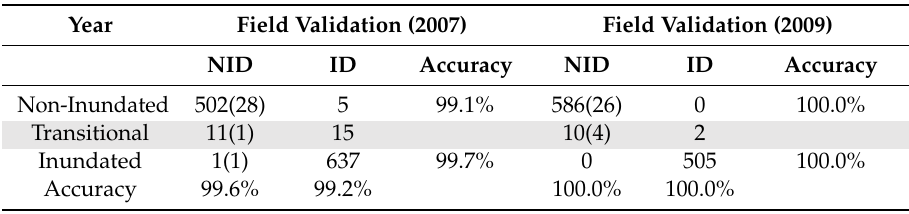
Table 1. Error matrices for 27 March, 2007 (left) and 24 March, 2009 (right). Field data indicating non-inundated (NID) and inundated (ID; top), are compared with map classes (side). Evergreen sites are indicated separately using parentheses, and were added to directly adjacent values when computing accuracy. User’s accuracy (i.e., how often the mapped class will be found in the field) is displayed vertically and producer’s accuracy (i.e., how often classes in the field are correctly classified in a map) is displayed horizontally. Overall accuracy is 99.4 % and 100.0 % for 2007 and 2009, respectively. Data for transitional field sites are indicated in gray. These numbers are included for visual reference only, and are not included in any derived estimates of accuracy.